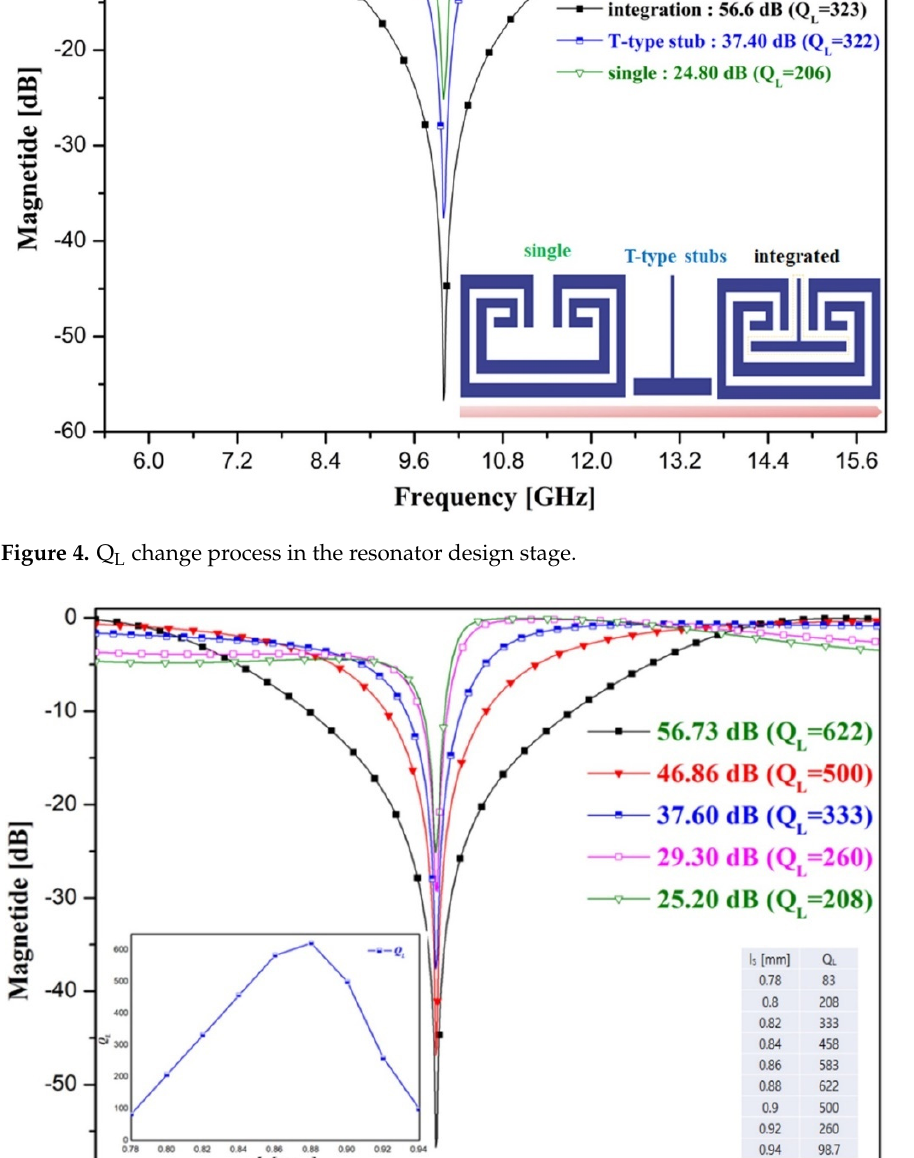
Figure 5. Q L change according to stub length adjustment.